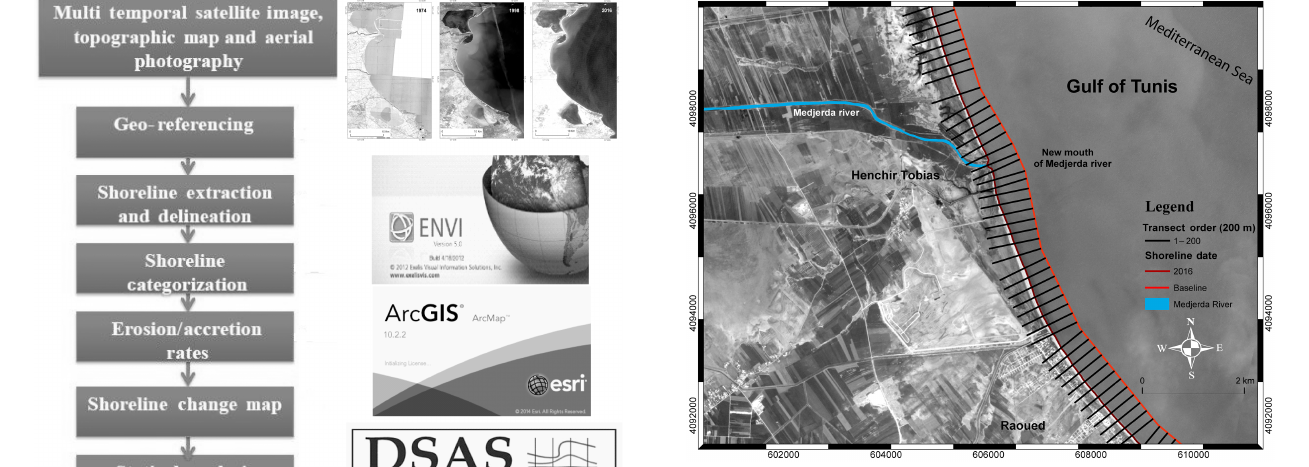
Figure 3. Shoreline extraction with transect and baseline using satellite imagery and maps in studied area. Table 2. Margin of error of